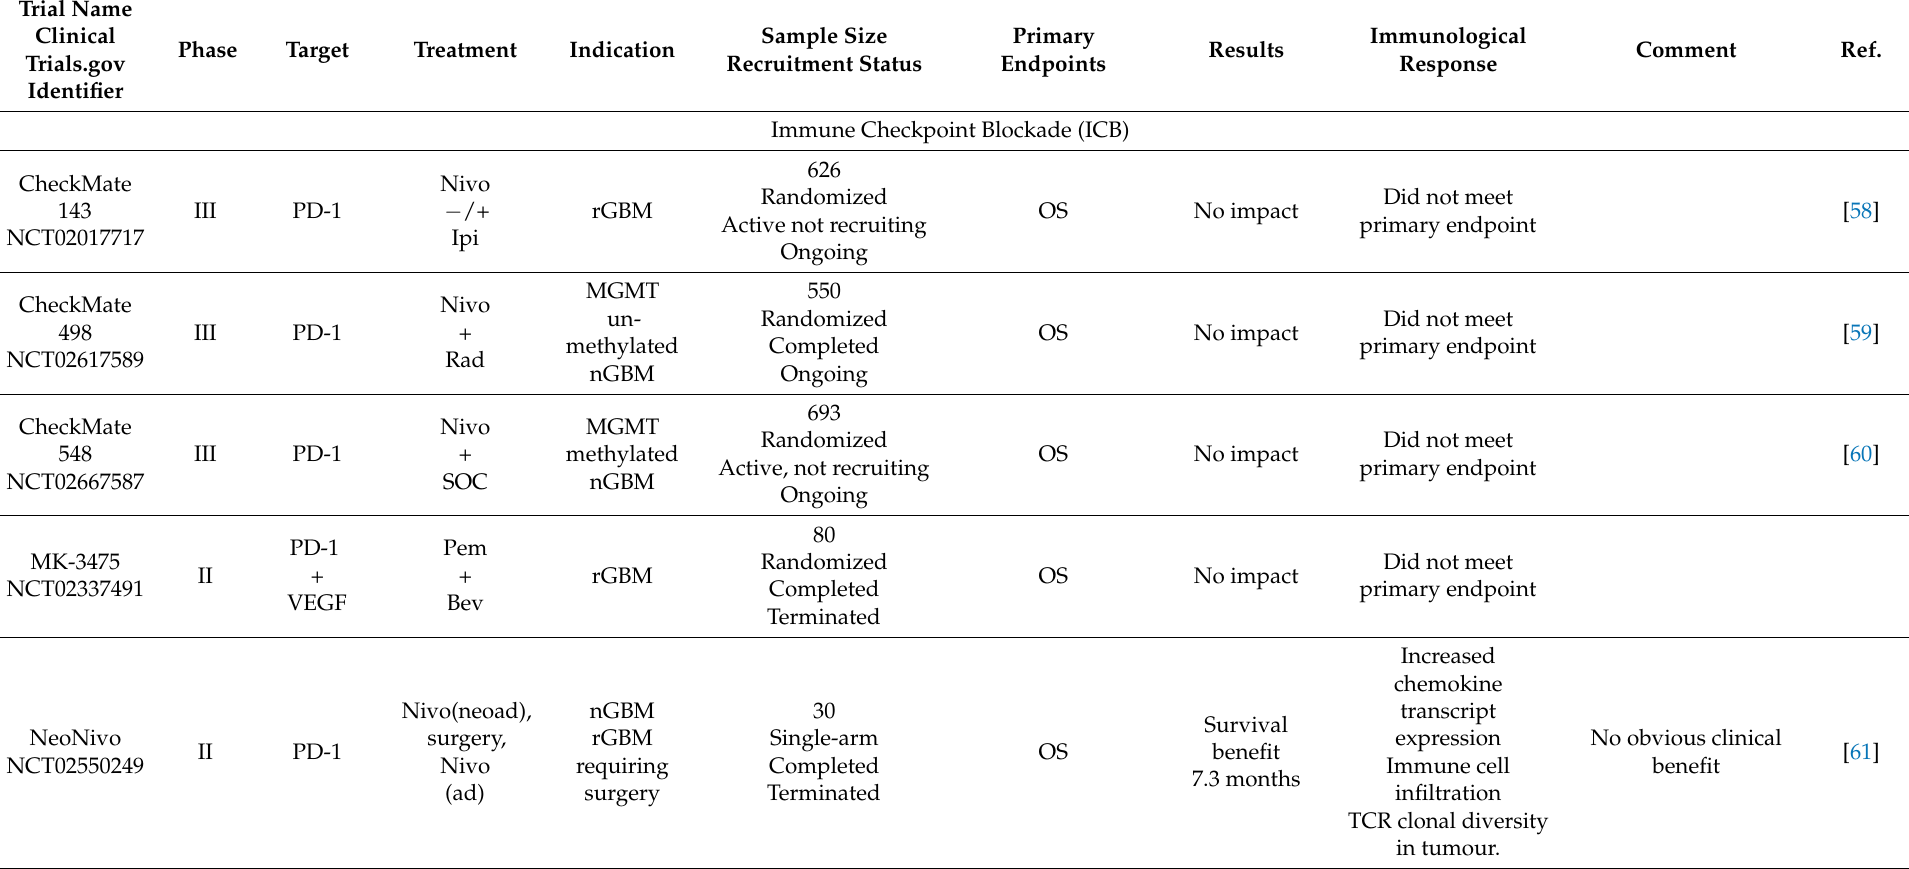
Table 1. Overview of the immune checkpoint blockade clinical trials in